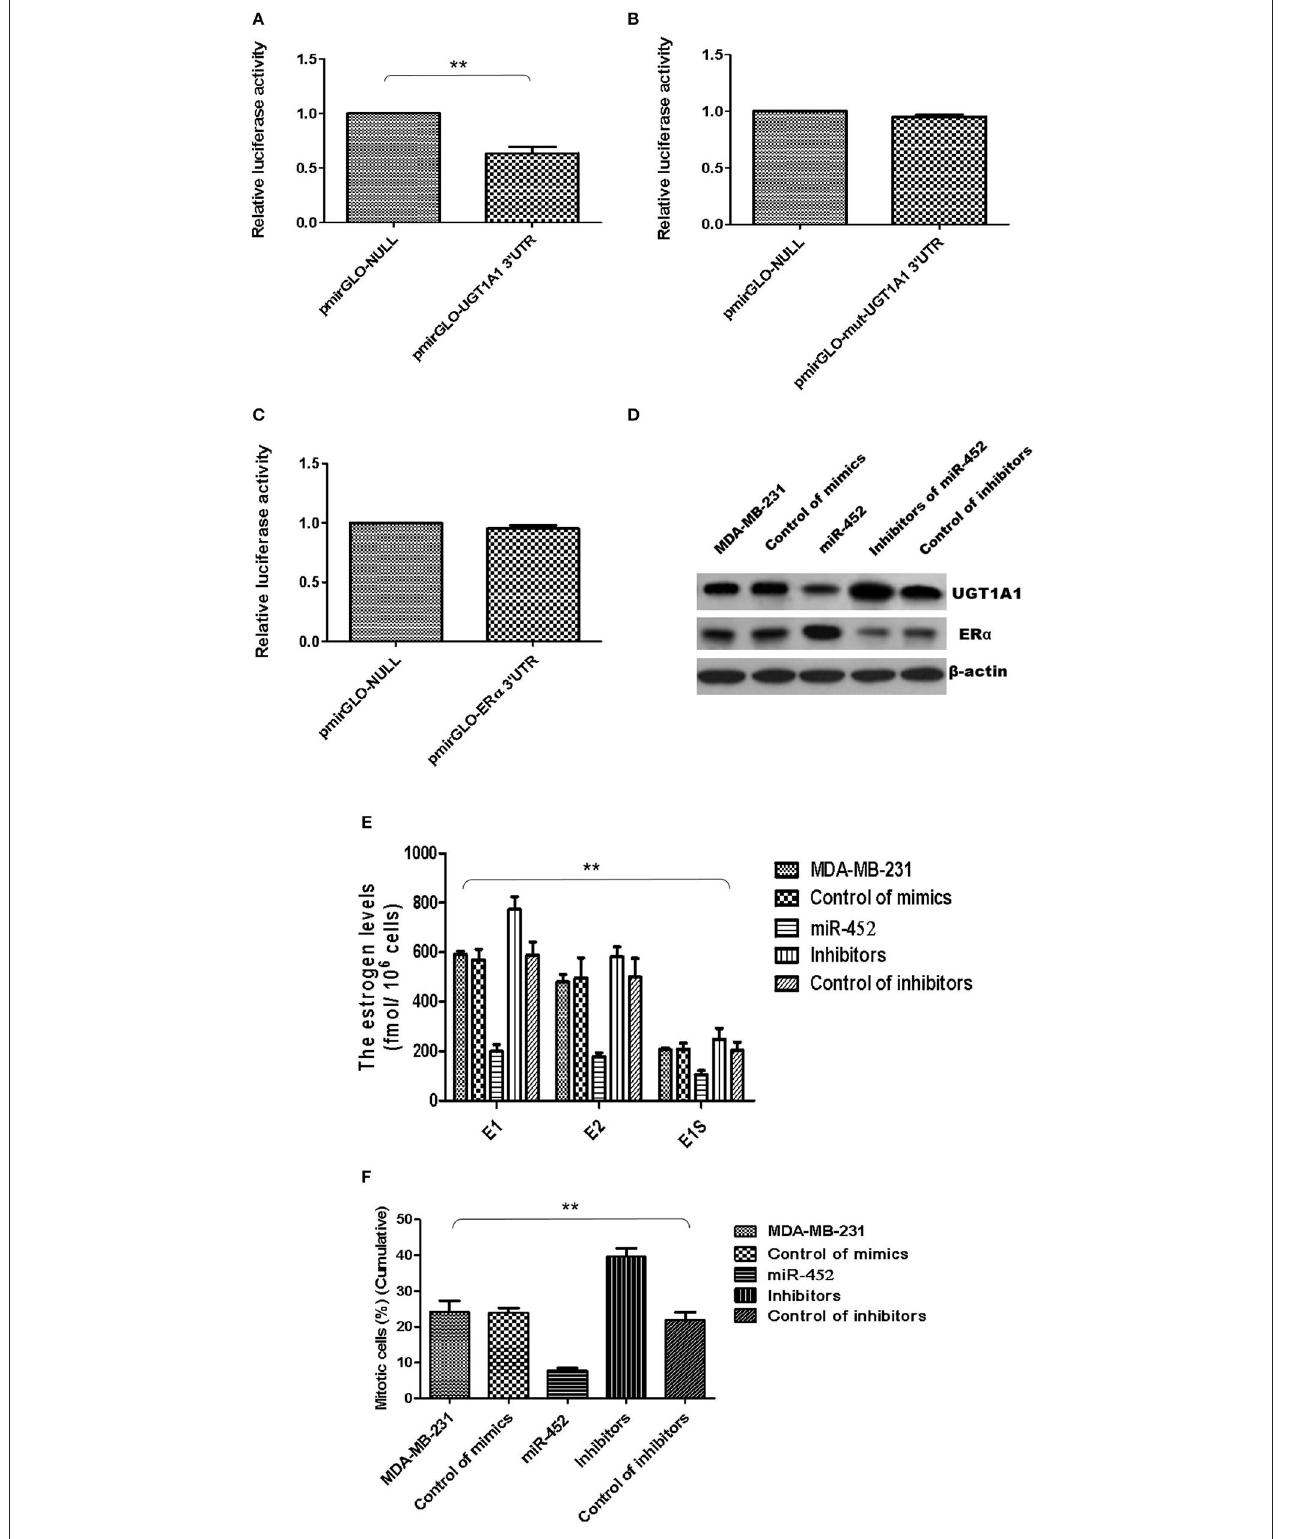
FIGURE 8 | miR-452 inhibited UGT1A1 expression and its bio-functions in TNBC. Further experiments were conducted using luciferase reporter gene system to identify whether miR-452 could straightly bind with 3 ′ UTRs of UGT1A1 mRNA. The data indicated 3 ′ UTR luciferase activities of UGT1A1 significantly downregulated